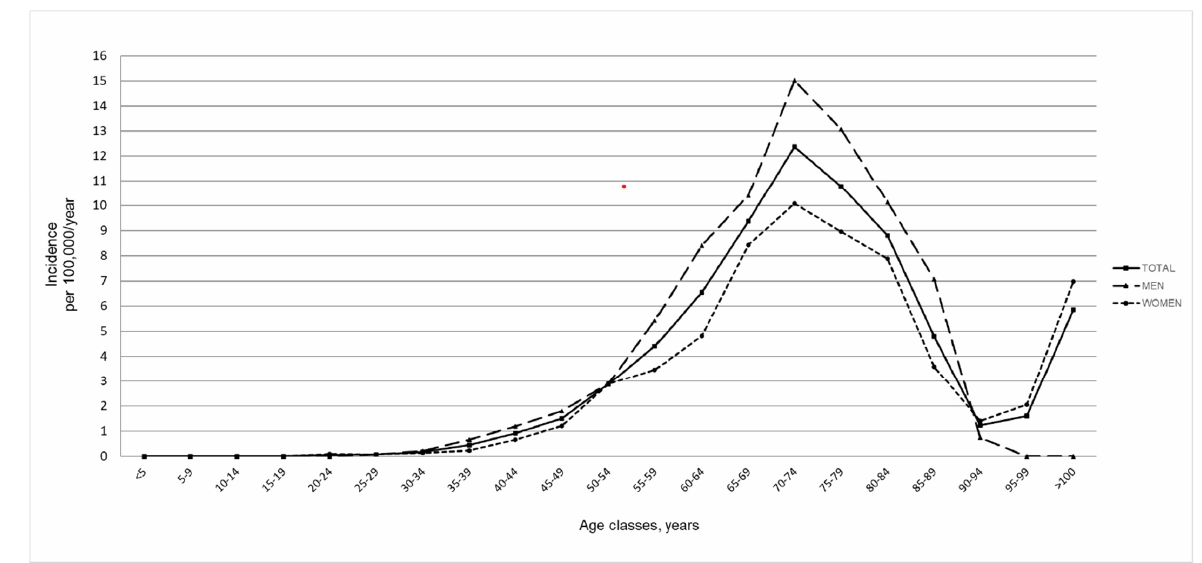
Figure 1. Incidence rates for 5–year age classes in males and females. Table 3. Demographic and clinical features of genotyped patients.